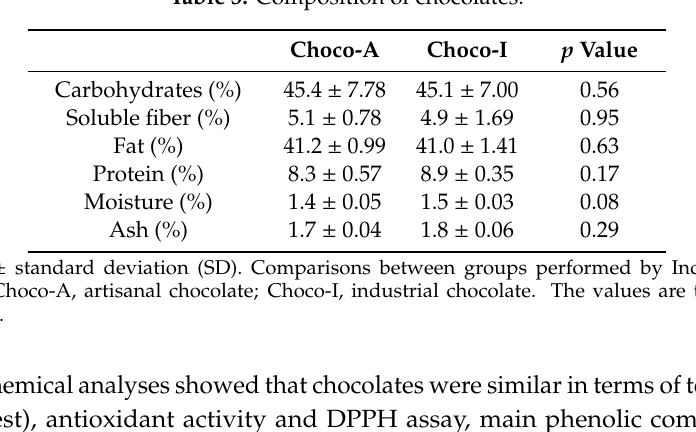
Table 3. Composition of chocolates.